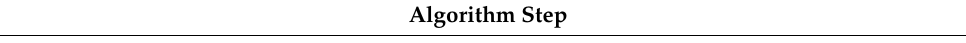
Table 2. The table of algorithm step for the analysis process of the optimal selection.